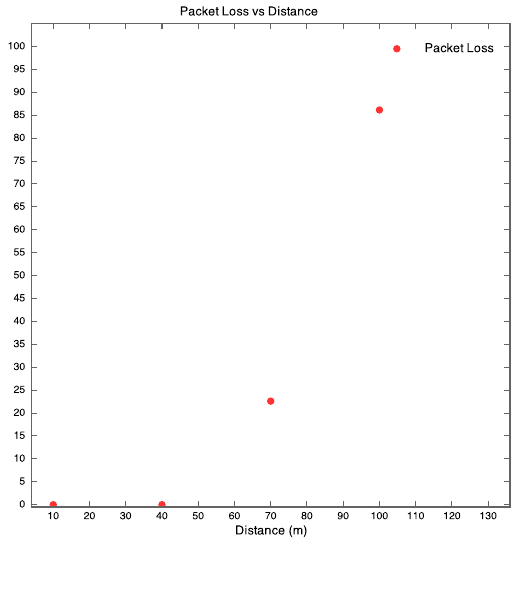
Figure 9. Packet Loss vs. Distance for Experiment 2.